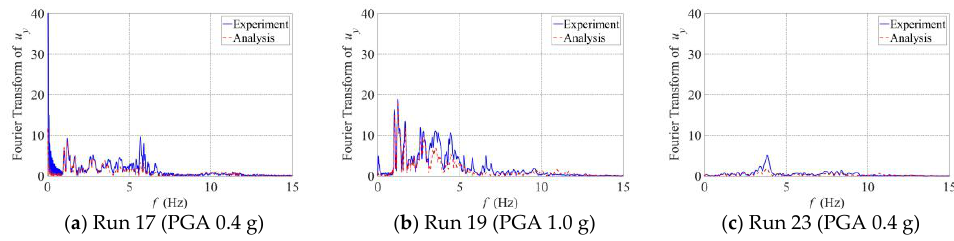
Figure 32. Frequency spectrum of the y directional displacement at point A on the third floor.